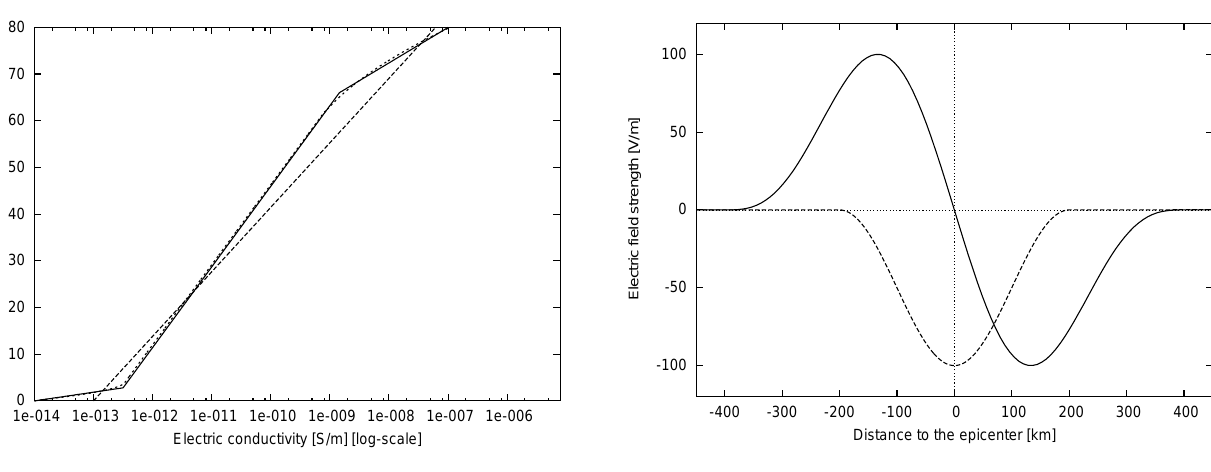
Fig. 2. Vertical electric field E z (x, 0 ) distribution at the Earth’s surface. The curves correspond to the bipolar electric field as con- sidered here (solid line), and the previous model by Denisenko et al. (2008) (dashed line). Both maximum values are 100Vm − 1